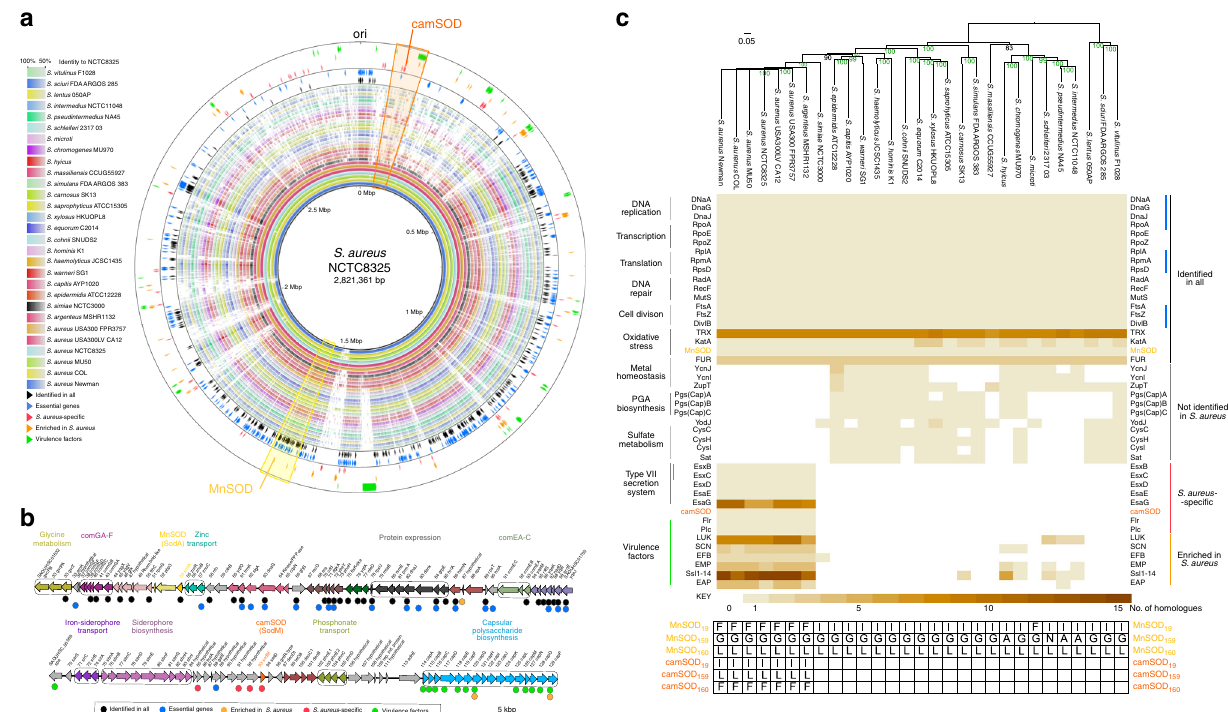
Fig. 5 Evolution of camSOD coincided with expansion of virulence factor network. a Circular genome alignment comparing 29 analyzed staphylococcal genomes, using S. aureus strain NCTC8325 as reference genome. The sodA gene (yellow), encoding MnSOD, is located in a genomic region enriched in essential genes (blue) that is highly conserved across the staphylococci, whereas the sodM gene (orange), encoding camSOD, is located in a variable genomic region enriched in virulence factors (green). b Expanded view of the local genomic context of the sodA (upper panel) and sodM (lower panel) genes. c Heatmap depicting the results from analysis of protein similarity networks, which identi fi ed protein families whose copy numbers (see color key) have been altered during evolution of the staphylococci (see phylogenetic tree in the upper panel). Protein families are represented on horizontal lines, and are grouped as Identi fi ed in all (black), Not identi fi ed in S. aureus (gray), S. aureus -speci fi c (red), Enriched in S. aureus (orange) as described in the Methods. Genes inferred to be essential in analyzed S. aureus genomes are illustrated by blue bars. The lower panel illustrates the amino acid residues present at positions 19, 159, and 160 of each SOD isozyme present in the respective